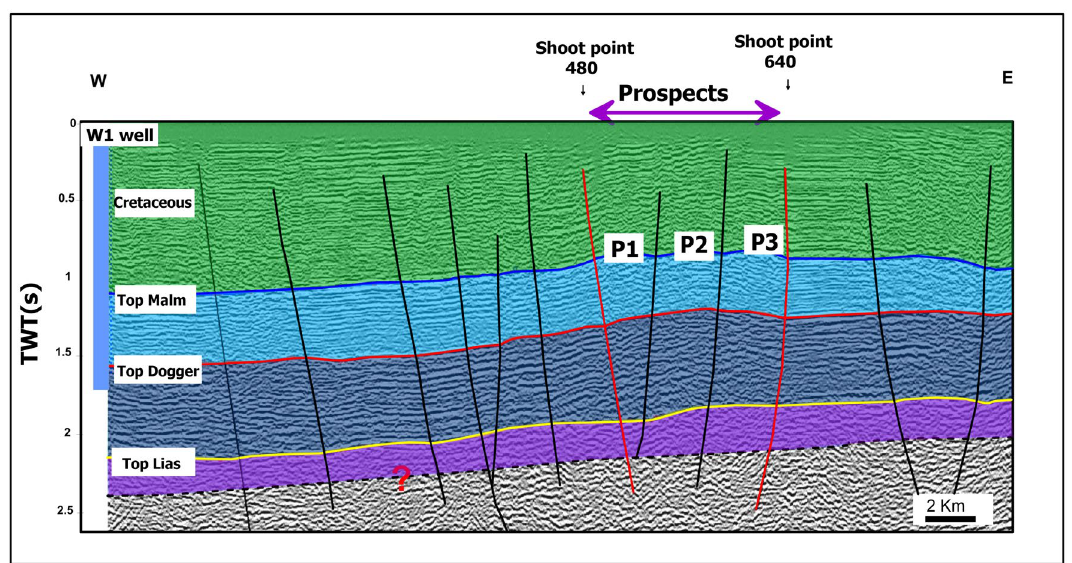
Fig. 11 Prospects identified from seismic interpretation. Example of “L3” profile